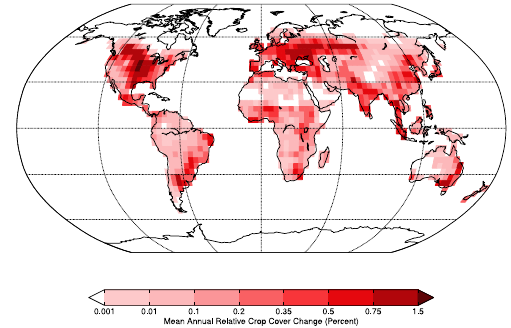
Fig. 7. Mean annual relative change in the crop cover, ¯ R C , due to historical anthropogenic land use (1959–2005). This measure of land use change is defined in Sect.